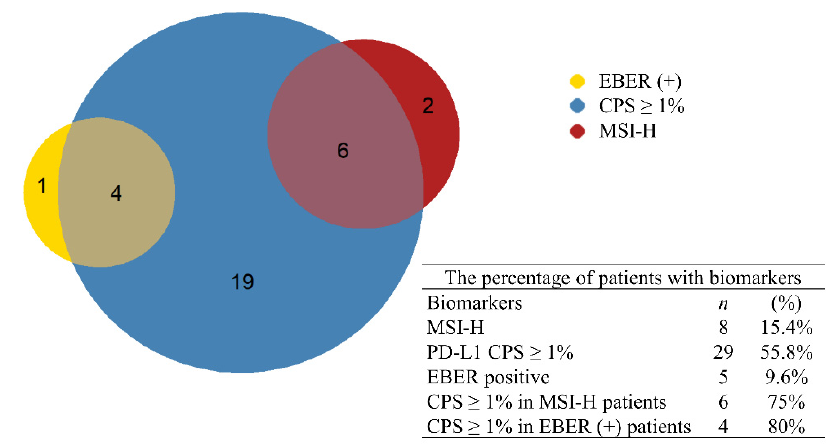
Figure 4. Incidence of biomarkers in gastric cancer patients. EBER: Epstein–Barr virus-encoded small RNAs; MSI-H: high microsatellite instability; PD-L1: programmed death ligand 1; CPS: combined positive score.